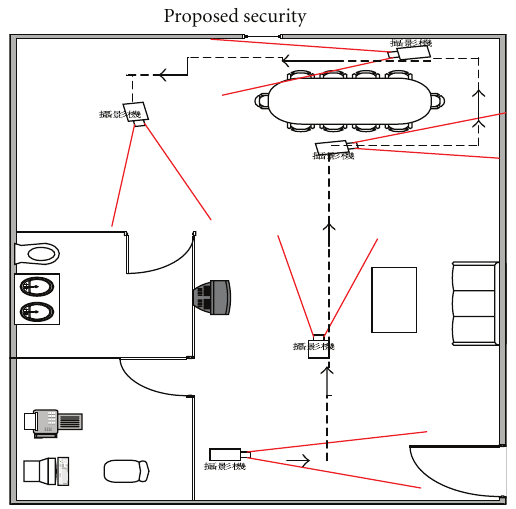
Figure 2: The proposed security